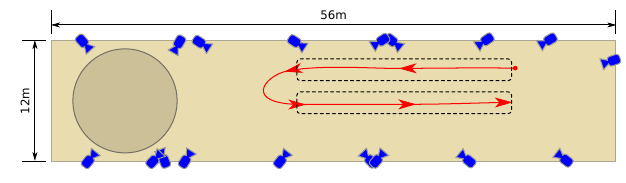
Figure 8. The experiment venue at Utrecht University including the approximate path of the horses.